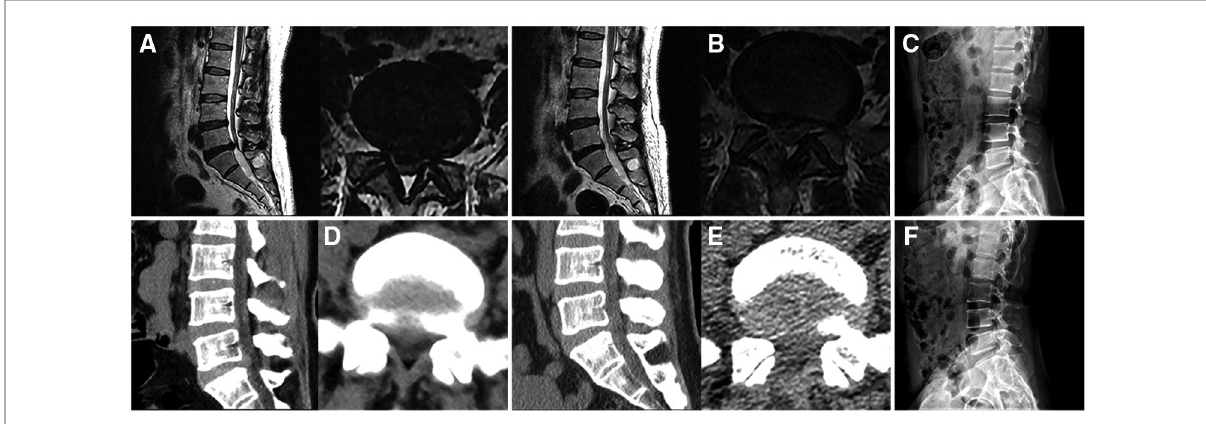
FIGURE 2 Images of a patient who underwent percutaneous endoscopic lumbar discectomy via the interlaminar approach. ( A ) A right L5 – S1 disc herniation is shown on preoperative magnetic resonance imaging. ( B ) Postoperative imaging shows removal of the herniated disc, preservation of the annulus fi brosus, and a defect in the ligamentum fl avum. ( C ) Preoperative lateral plain radiography of the lumbar spine. ( D ) L5 – S1 disc herniation on preoperative computed tomography. ( E ) A window in the lamina and defects in the ligamentum fl avum are seen after surgery. ( F ) Postoperative lateral plain radiography for the lumbar